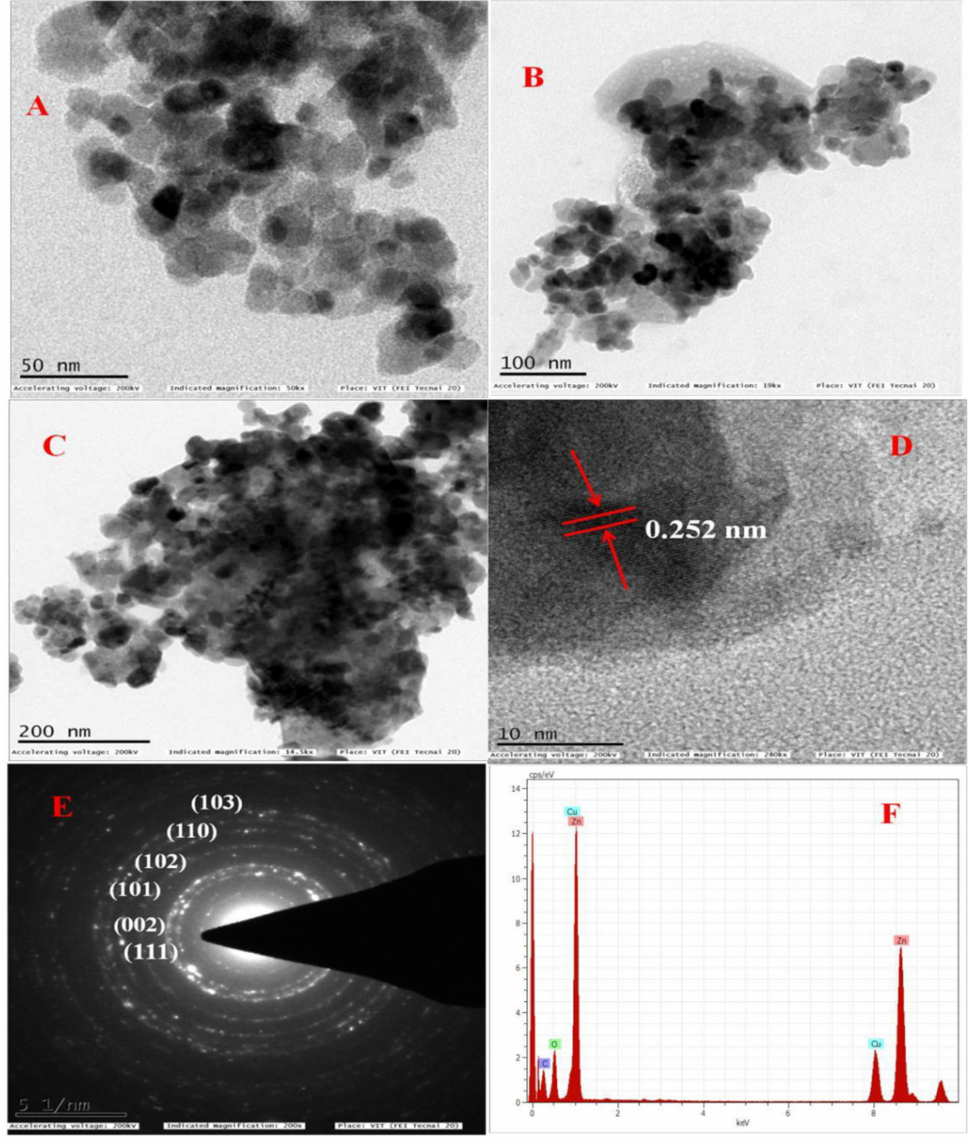
Figure 6. TEM images showing the ZnO-NPs at different magnifications: ( A ) (50 nm), ( B ) (100 nm), ( C ) (200 nm); ( D ) represents the d-spacing, ( E ) denotes the SEAD pattern of polycrystalline, ( F ) rep-resents the EDAX analysis of the